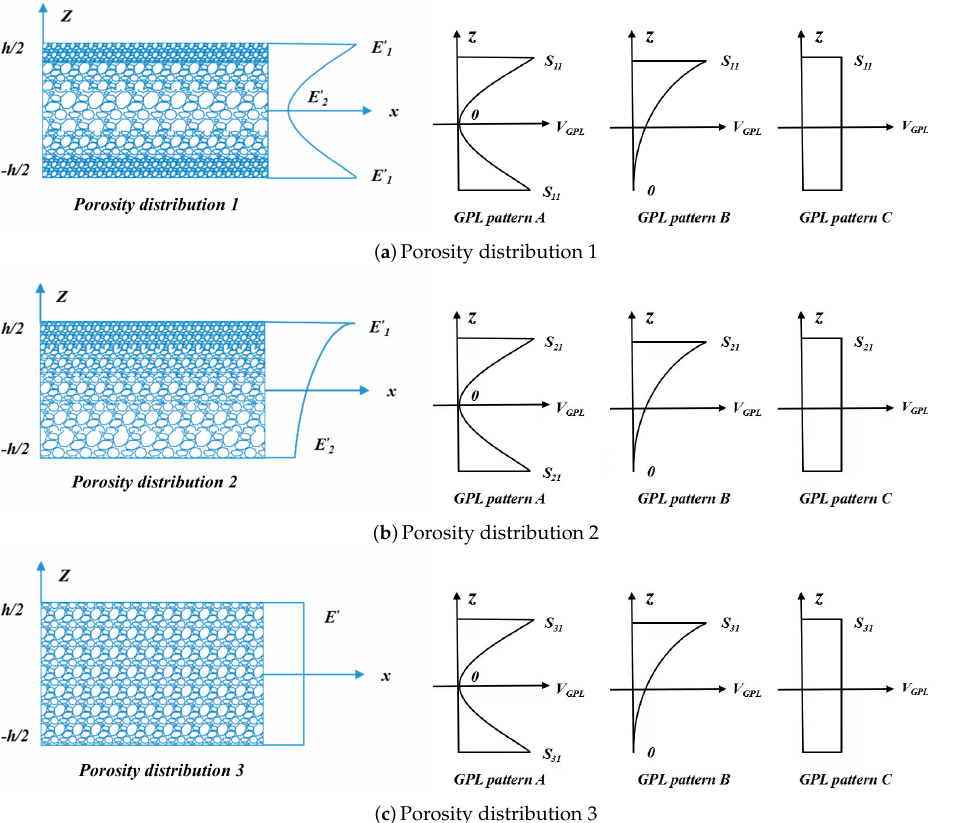
Figure 2 considers three porosity distributions and GPL patterns. Because of disparate dispersion patterns, GPL patterns can be divided as A, B, and C, and the GPLs volume content V GPL is smoothly on the z-axis. According to different porosity distributions, V GPL ’s peak values can be denoted as s ij ( i , j = 1, 2, 3 ) . Assuming three GPL patterns have the same total amount of GPLs will result in s 1 i (cid:54) = s 2 i (cid:54) = s 3 i . E (cid:48) and E (cid:48) are denoted as the maximum and minimum elastic moduli of the non- 2 1 uniform porous beams without GPLs, respectively. In addition, E (cid:48) represents the elastic moduli of the uniform porosity distribution beams.